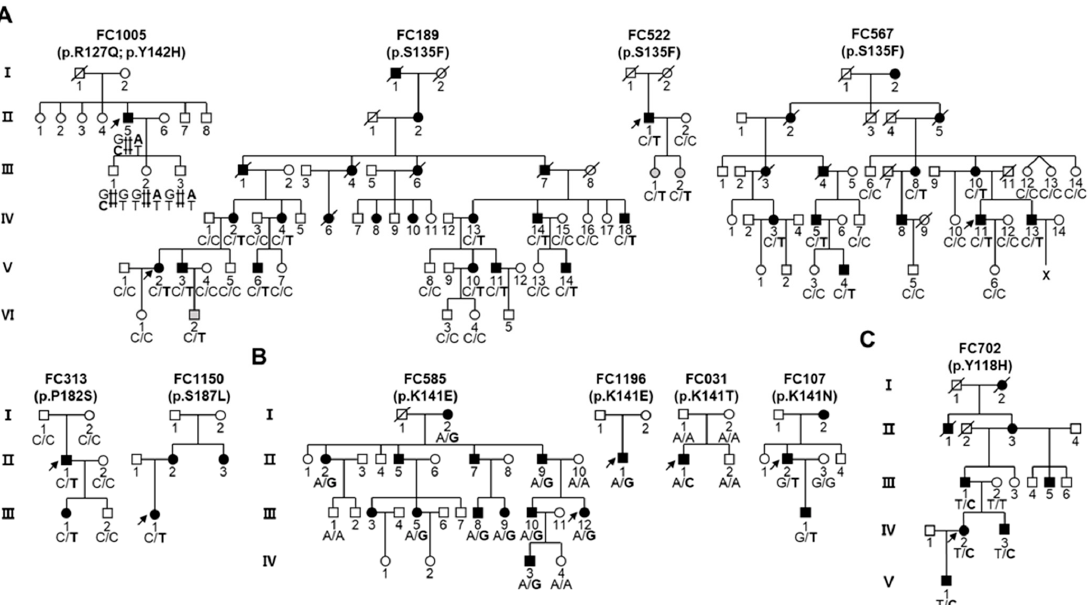
Figure 1. Inherited peripheral neuropathy families with small heat shock protein gene mutations. Genotypes of the interested variants are provided at the bottom of all examined family members. Arrows indicate the proband (unfilled symbols ( □ , ○ ): unaffected individuals; black-filled symbols ( ■ , ● ): affected individuals; gray-filled symbols: unaffected individuals having corresponding mutation; ˄ : twins). ( A ) Pedigrees with HSPB1 mutations. ( B ) Pedigrees with HSPB8 mutations. ( C ) Pedigree with HSPB3 mutation.